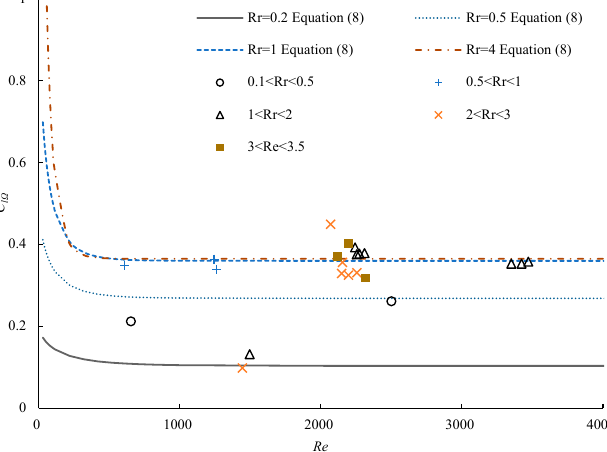
Figure 6. Correlation between the lift coefficient and the Reynolds number.